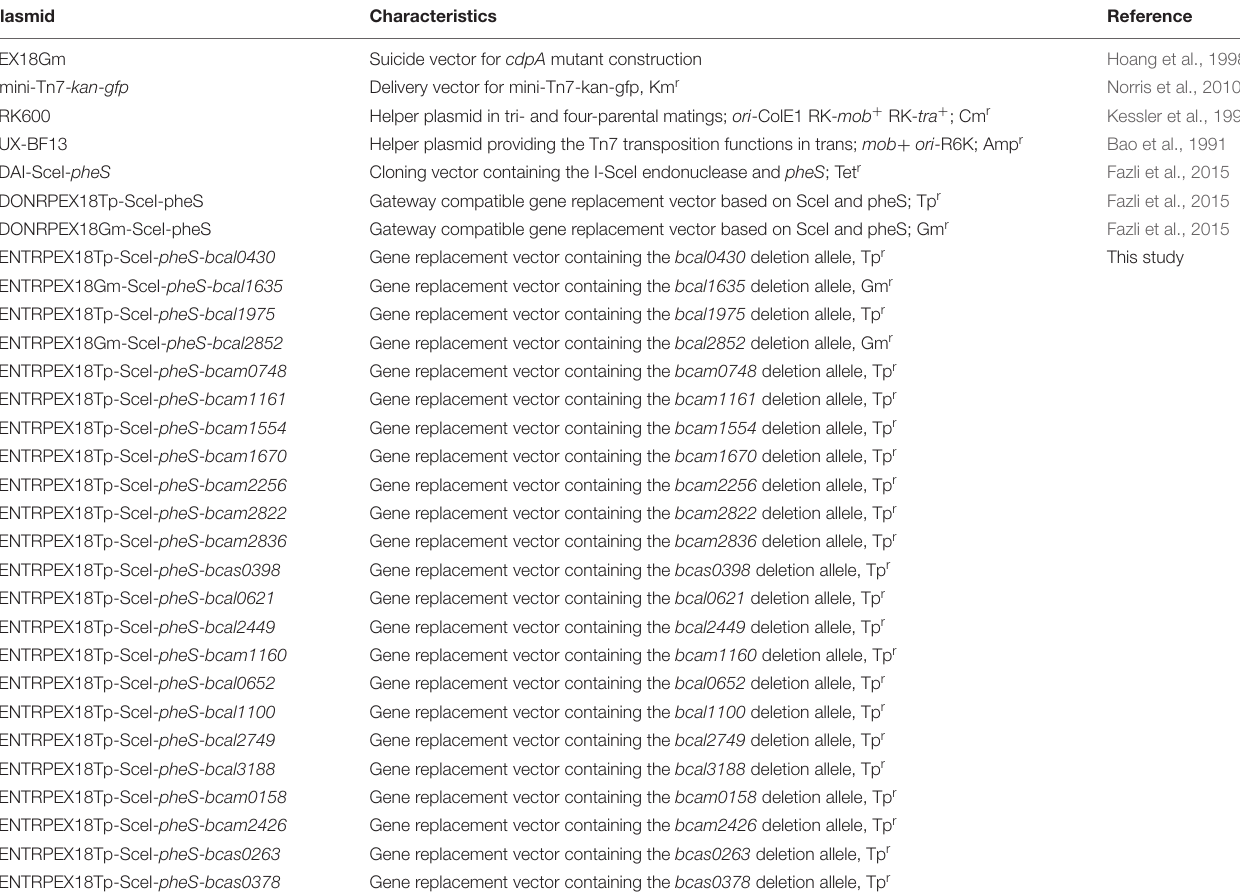
TABLE 2 | Plasmids used in this